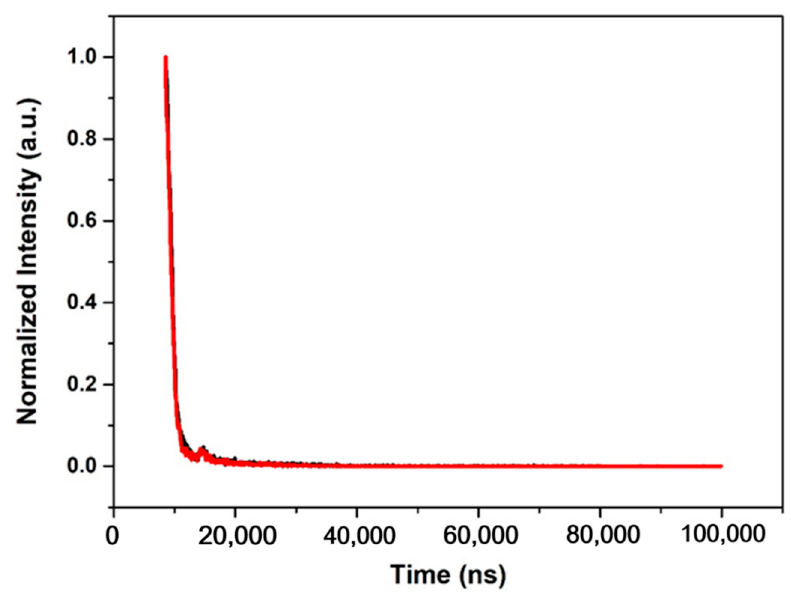
Figure 8. Luminescent decay curves of 1 (red) and 2 (blue).